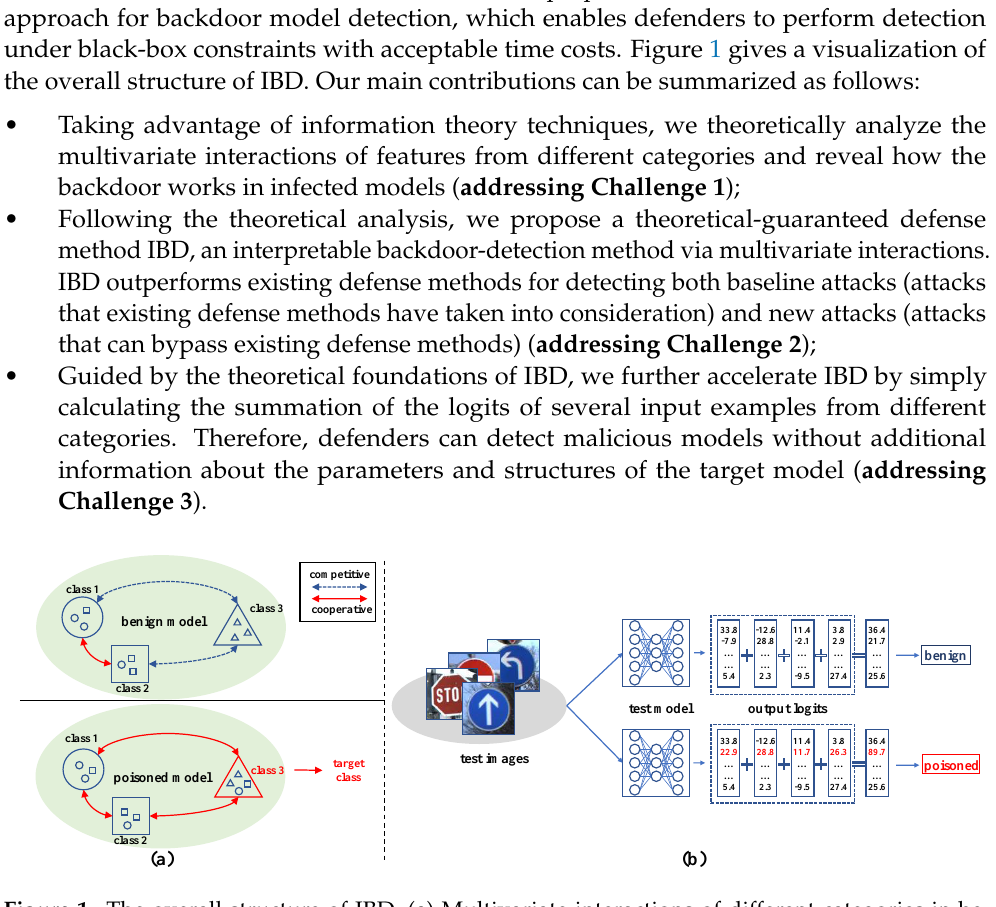
Figure 1. The overall structure of IBD. ( a ) Multivariate interactions of different categories in be- nign and poisoned models. ( b ) A multivariate-interaction-based simple approach for backdoor model